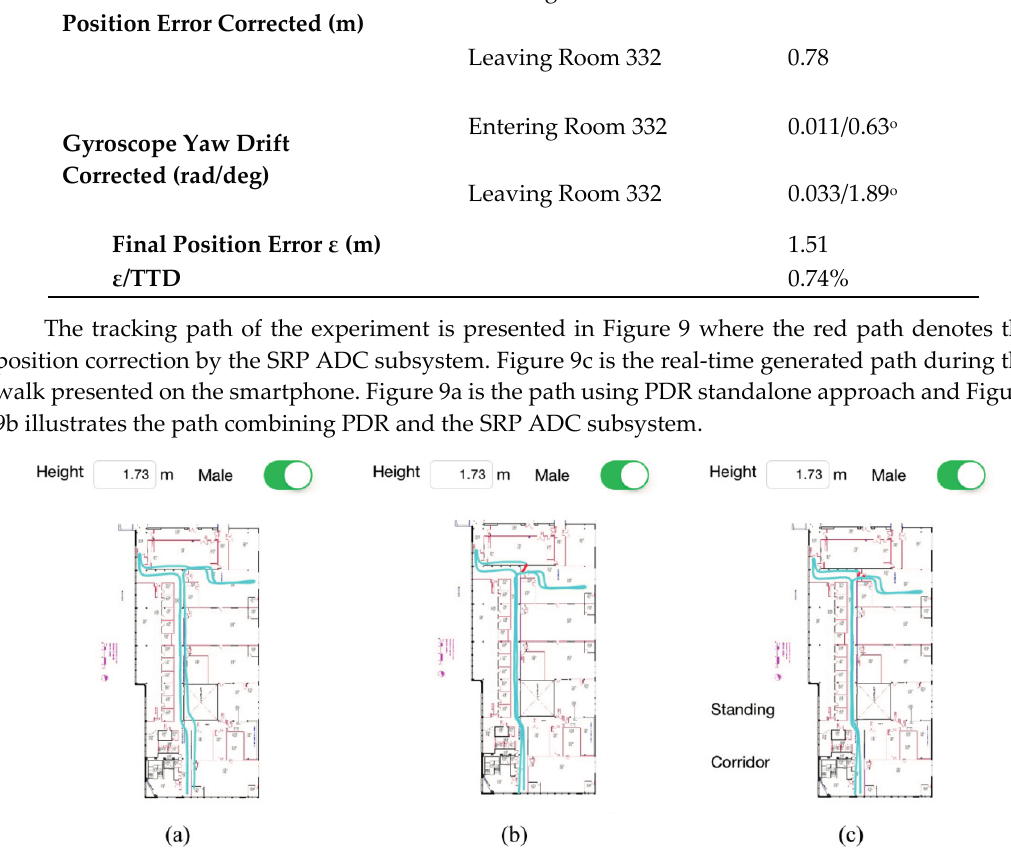
Figure 9. Tracking path of the second short-term experiment ( a ) PDR standalone ( b ) PDR + SRP ADC ( c )